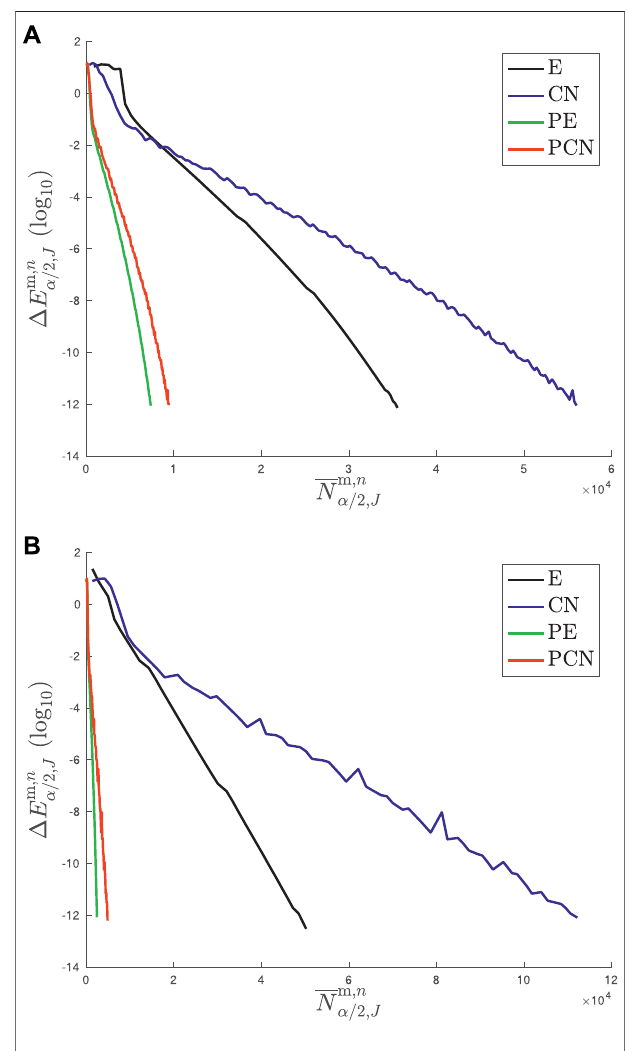
FIGURE 2 | 1d case: (A) ( α = 1.5 ) and (B) ( α = 1.9 ): energy residual history of the E, PE, CN and PCN methods.